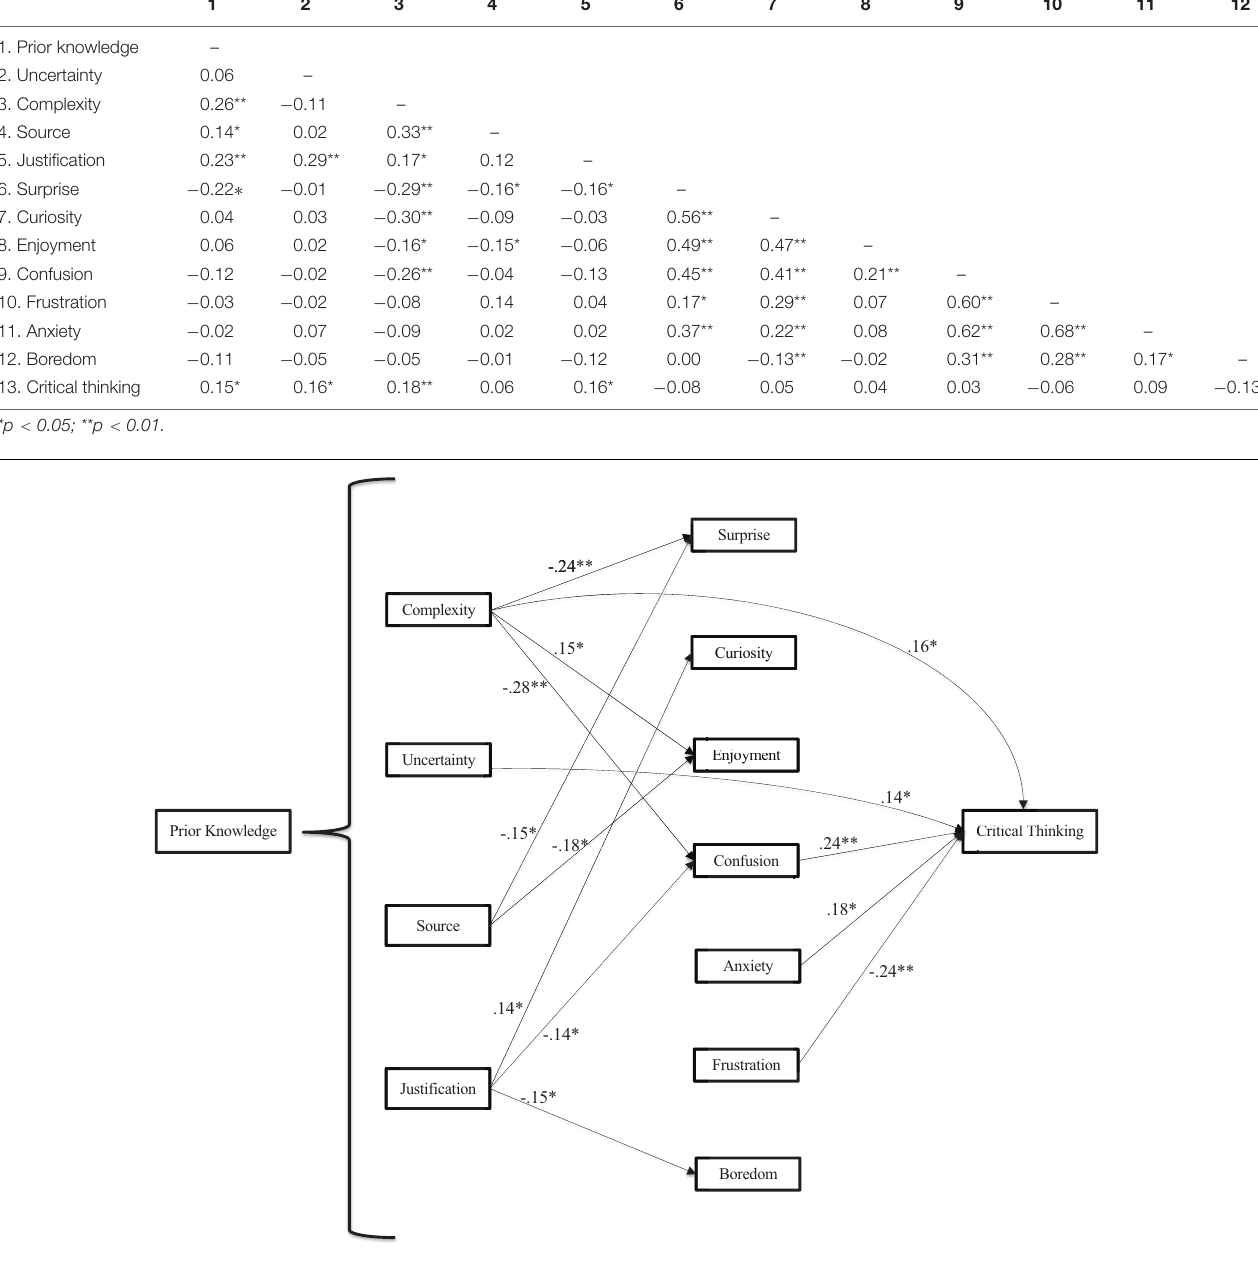
FIGURE 2 | Final model with standardized coefficients. Only significant paths are represented. * p < 0.05; ** p <